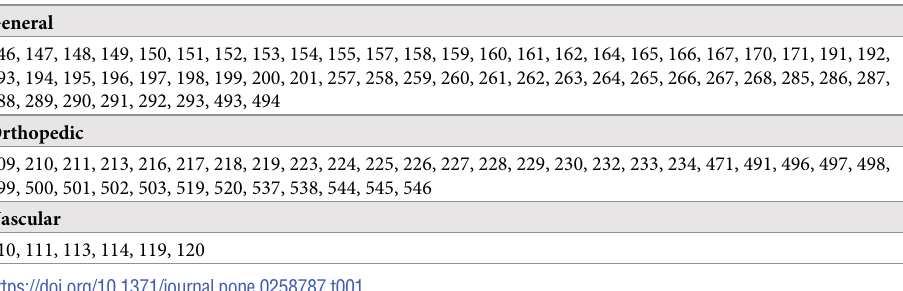
Table 1. Surgical patient diagnosis related group